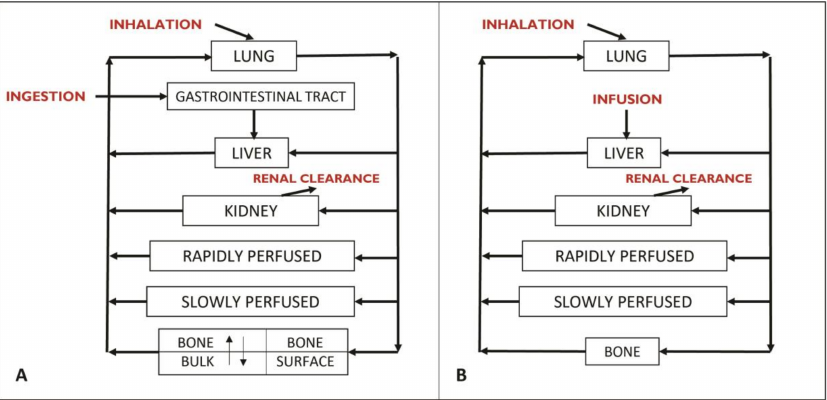
Figure 1. Conceptual diagram of ( A ), the original PBPK model of Rao et al. [23] and ( B ) the PBPK model simplified for the purposes of this work. Each box represents a compartment (an organ or a set of organs). The arrows symbolize the distribution of fluoride through the